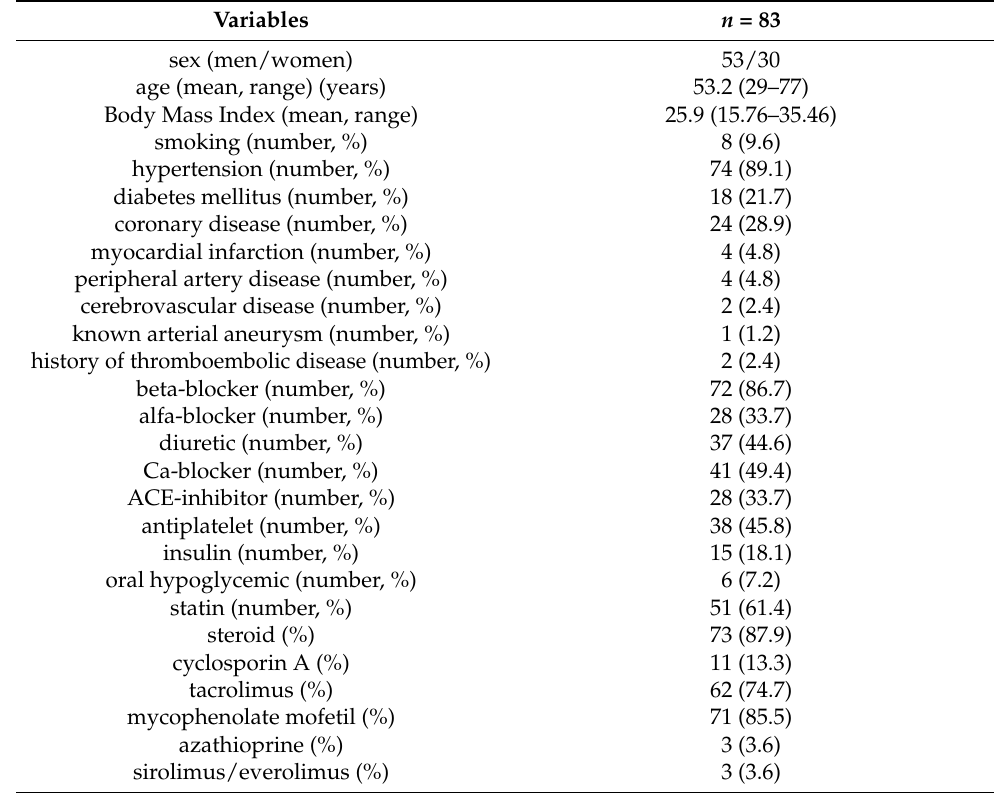
Table 1. The kidney transplant recipients with corrected dialysis fistula aneurysm—patient charac- teristics and used immunosuppressive